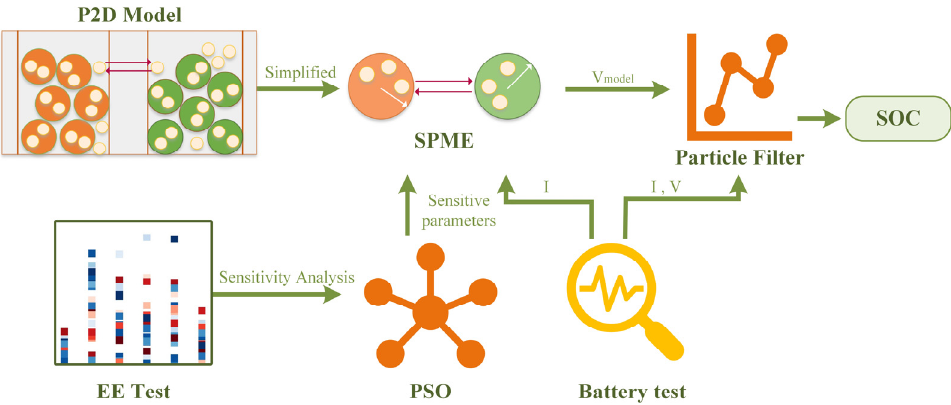
Figure 4. The framework of the online SOC estimation based on electrochemical model using PF4.